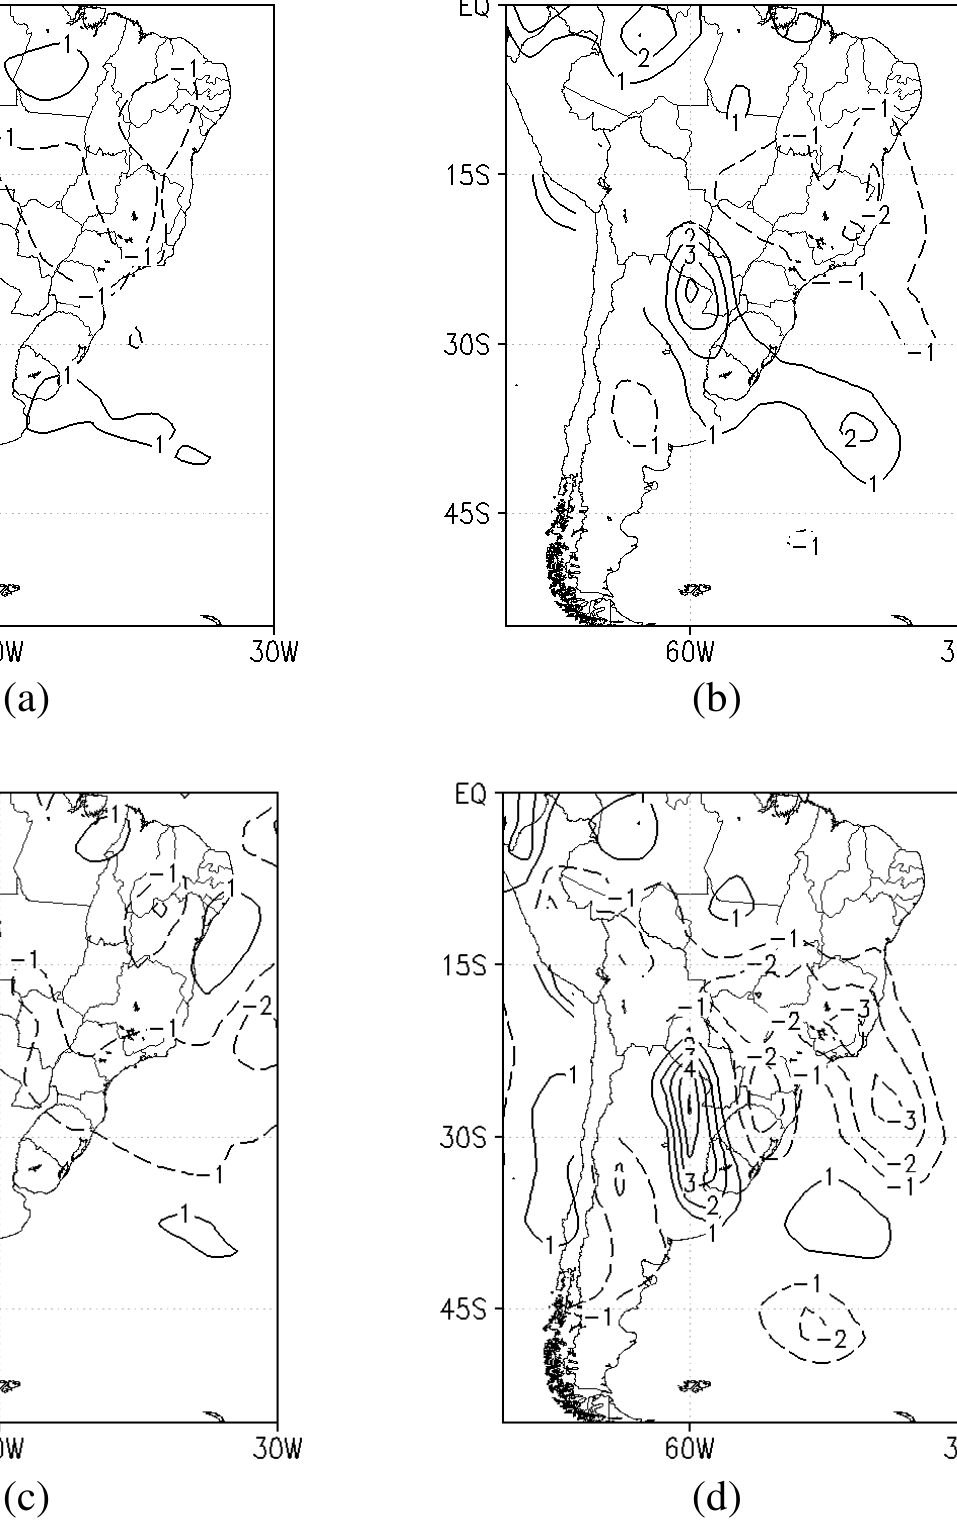
Fig. 16. Five-day mean fields of vertical advection of humidity (gkg − 1 day − 1 ) in the development stage of the WDS: (a) 700hPa, Case 29, Fig. 16 – Five-day mean fields of vertical advection of humidity at 700 hPa (g kg -1 day -1 ) in (b) 700hPa, Case 32, (c) 850hPa, Case 29, and (d) 850hPa, Case the development stage of the WDS. (a) 700 hPa, Case 29, (b) 700 hPa, Case 32, (c) 850 hPa, Case 29, and (d) 850 hPa, Case 32.